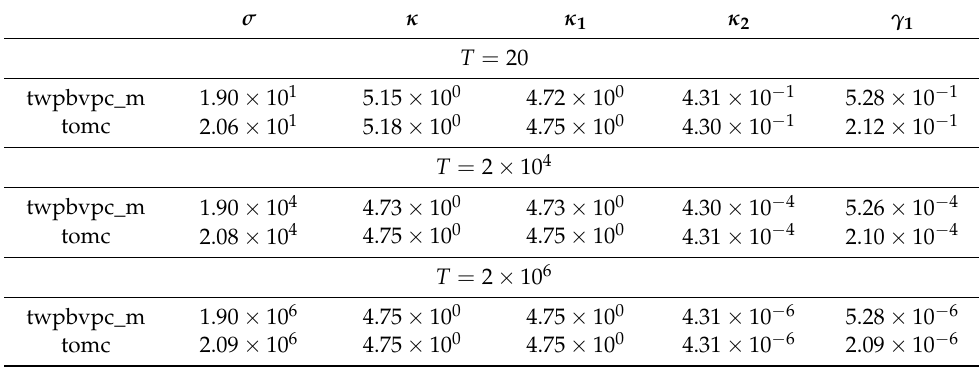
Table 6. Nonlinear Mass spring using the variable τ = t / T : conditioning parameters computed using tol = 10 − 6 and initial mesh with 11 equidistant points.